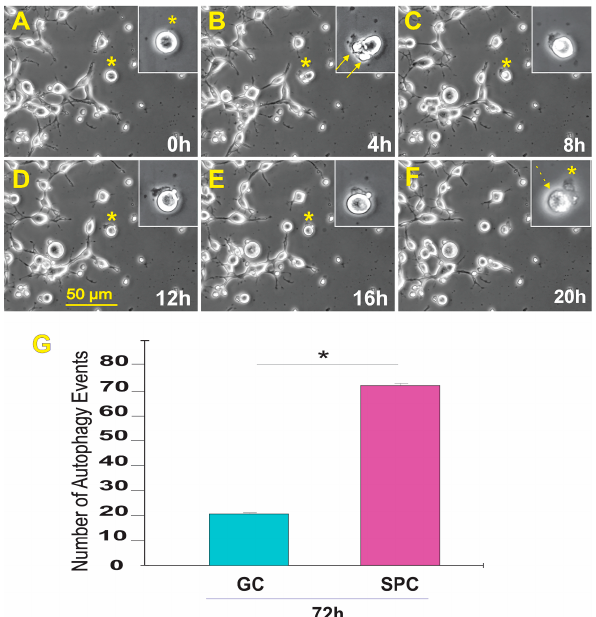
Figure 7. The field was examined to identify OLPs undergoing autophagy. Once a cell was identi ‐ fied, it was then studied using reverse ‐ time tracking. ( A ) View of the round cell being studied 0 = 13.25 h after the start of the time ‐ lapse capture. ( B ) Morphological changes occur where bleb ‐ like structures are seen (arrows). The inset shows that the cell has left flat membrane ‐ like material out ‐ side. ( C ) 8 h after, the cell changed morphology, looking like one round structure. ( D ) During the lapse of 4 h, the cell had deposited some of its contents onto the extracellular space. ( E ) Four hours later, the cell appeared to have internalized part of the expelled material, ( F ) The cell then contracted until there was just a small pocket ‐ like structure and an empty sac ‐ like structure. The event was completed within the lapse of 20 h—also see supplemental time lapse (TL) TL ‐ 1. ( G ) This bar graph shows the incidence of autophagic cell death in GC and SPC ‐ flown OLPs three weeks after returning to Earth. The average total number of cells per field displaying autophagy in the GC group was 22